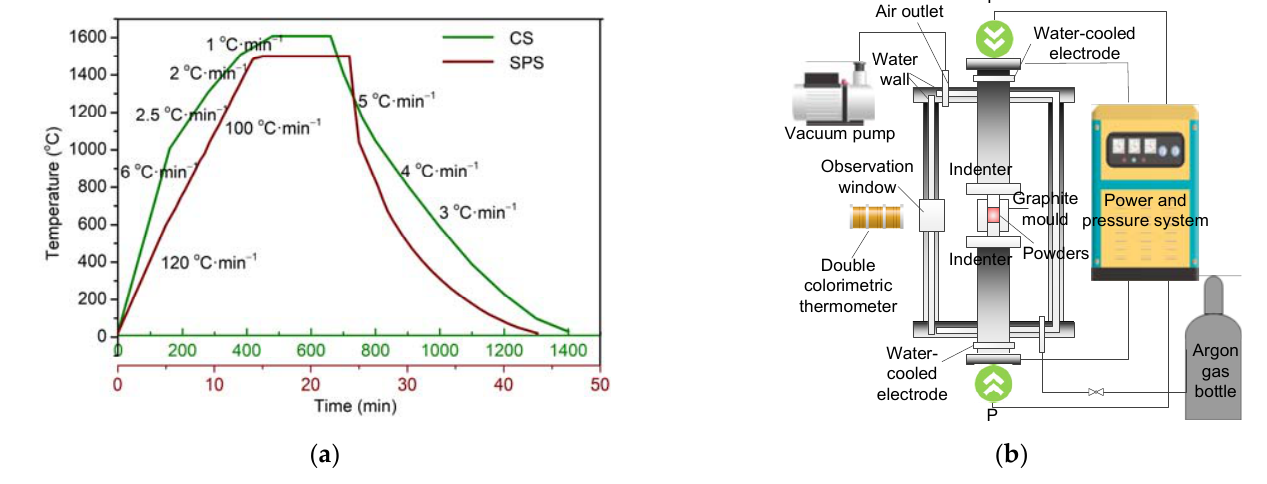
Figure 2. ( a ) CS and SPS temperature program ( b ) schematic diagram of SPS